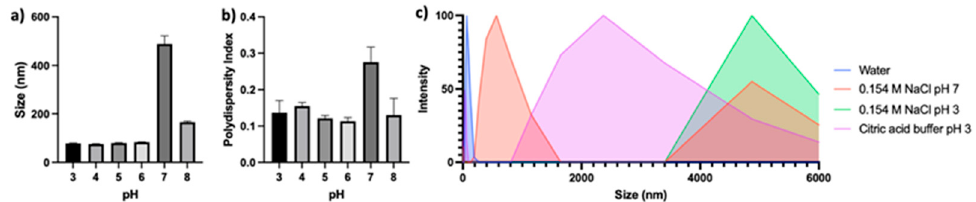
Figure 1. Stability of Zein nanoparticles (Zein NPs; 70 +/ − 10 nm upon synthesis) in varying conditions: ( a ) Size of Zein NPs at a pH ranging from three to eight unbuffered and adjusted directly with HCl or NaOH; ( b ) polydispersity of Zein NPs at a pH ranging from three to eight unbuffered and adjusted directly with HCl or NaOH; and ( c ) intensity histogram of Zein NP size in water, 0.145 M NaCl at pH 7, 0.145 M NaCl at pH 3 unbuffered and adjusted directly with HCl, and citric acid buffer at pH 3.